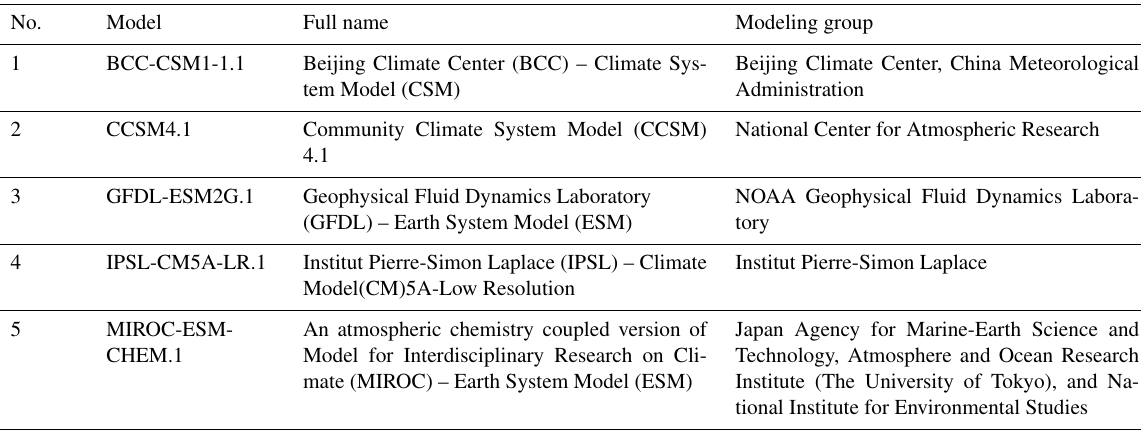
Table A2. Five general circulation models (GCMs) used to construct the GCM scenario.